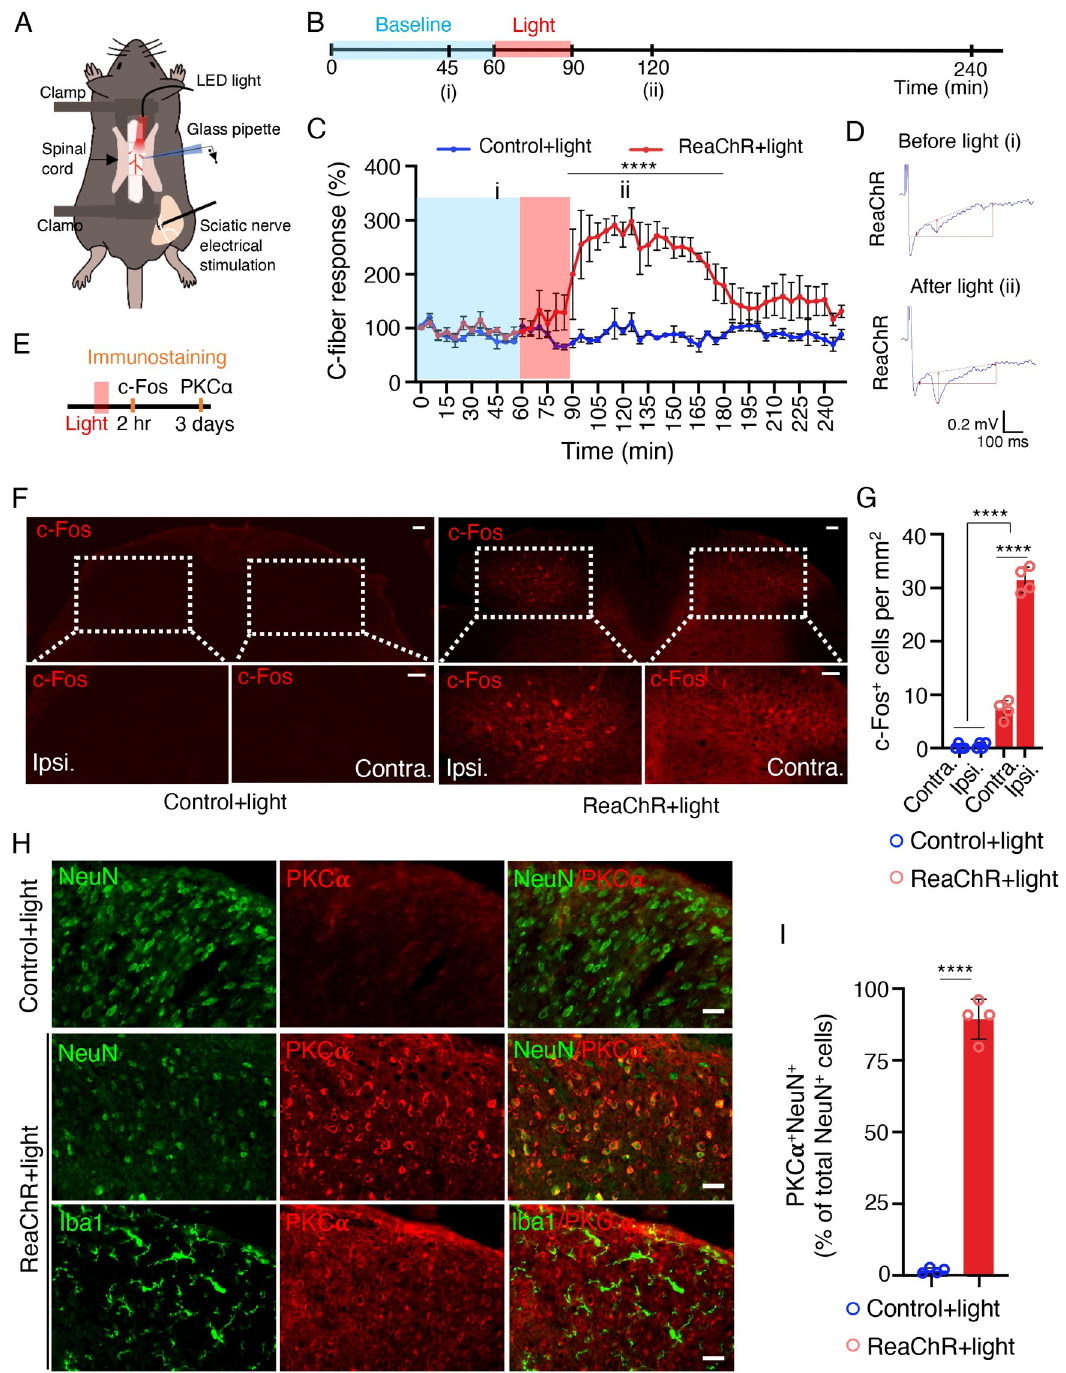
Fig 5. Optogenetic stimulation of microglia increases neuronal activity. (A) A schematic figure shows optogenetic stimulation and C-fiber–evoked field potential in vivo recording in mice. (B) Timeline of experimental procedures for optogenetic stimulation and in vivo electrophysiology. (C) Pooled results showing the time course of C-fiber–evoked field potentials following optogenetic stimulation of spinal microglia in ReaChR or control mice. Light stimulation enhances C-fiber responses for more than 60 min in ReaChR mice but not in control mice. C-fiber–evoked field potential was normalized to the baseline. n = 4 mice/group. ���� P < 0.0001. Two-way ANOVA with multi-comparisons. (D) Representative traces of C-fiber–evoked field potentials from ReaChR mice recorded at 45 min of baseline (i) and after light stimulation, 60 min (ii). The amplitude of C-fiber–evoked response (red vertical line) was determined with parameter extraction software WinLTP. n = 5 mice/group. Scale bars, 100 ms (X) and 0.2